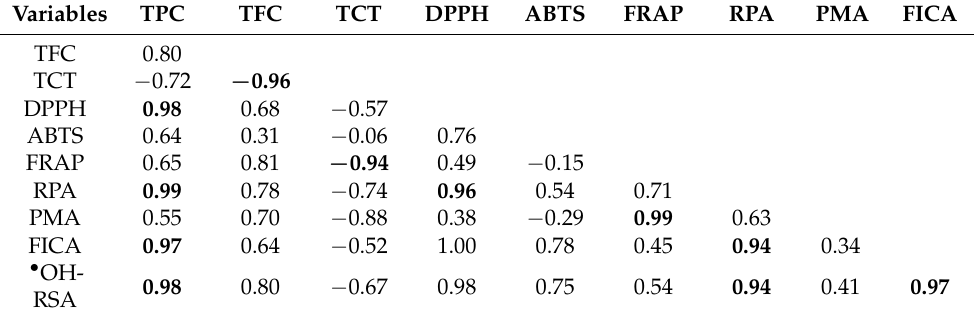
Table 2. Pearson correlation of phenolic contents and antioxidant activities in Australian native